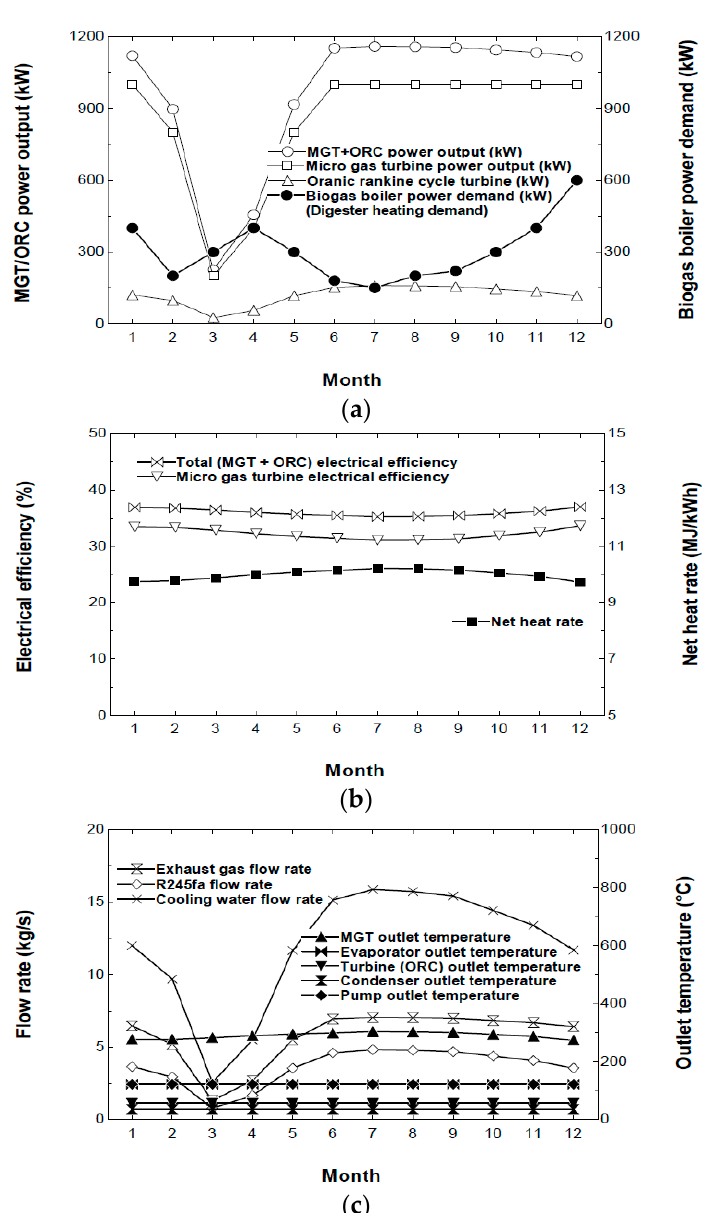
Figure 9. Annual operating results for MGT with bottoming ORC and biogas boiler system. ( a ) The power output of the MGT and the ORC and the amount of the biogas used in the biogas boiler; ( b ) The electrical efficiency of the MGT and the MGT with the ORC. The net heat rate of the MGT with the ORC; ( c ) The mass rate and the outlet temperature for the streams in the MGT and the ORC.